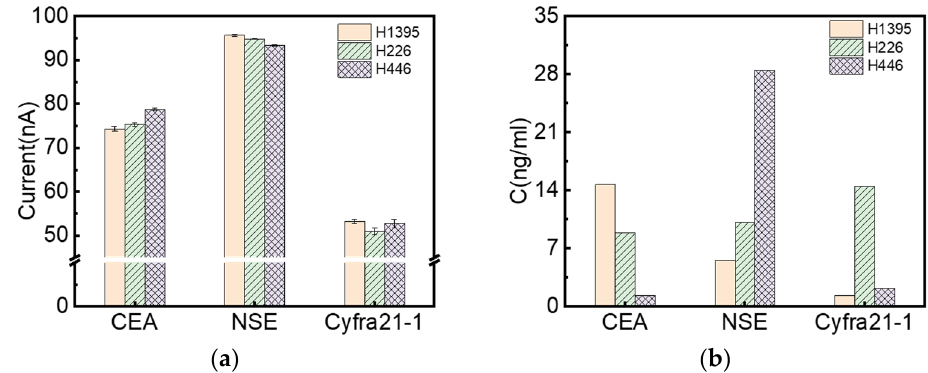
Figure 10. Quantitative detection of markers of exosomes extracted from H1395, H226, and H446 lung cancer cells, respectively. DPV response ( a ) and concentration expression ( b ) of three markers of exosomes measured in different cell lines.